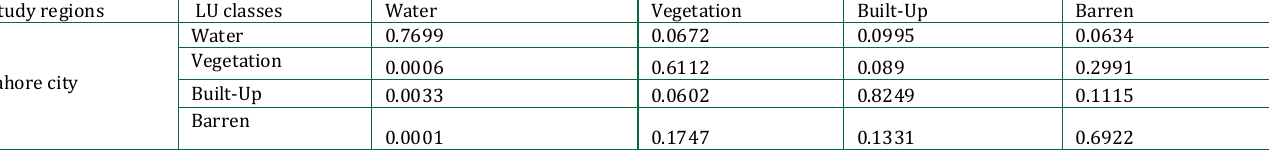
Table 4 : variations and trends of different land use classes in Lahore 1998-2018. Study regions